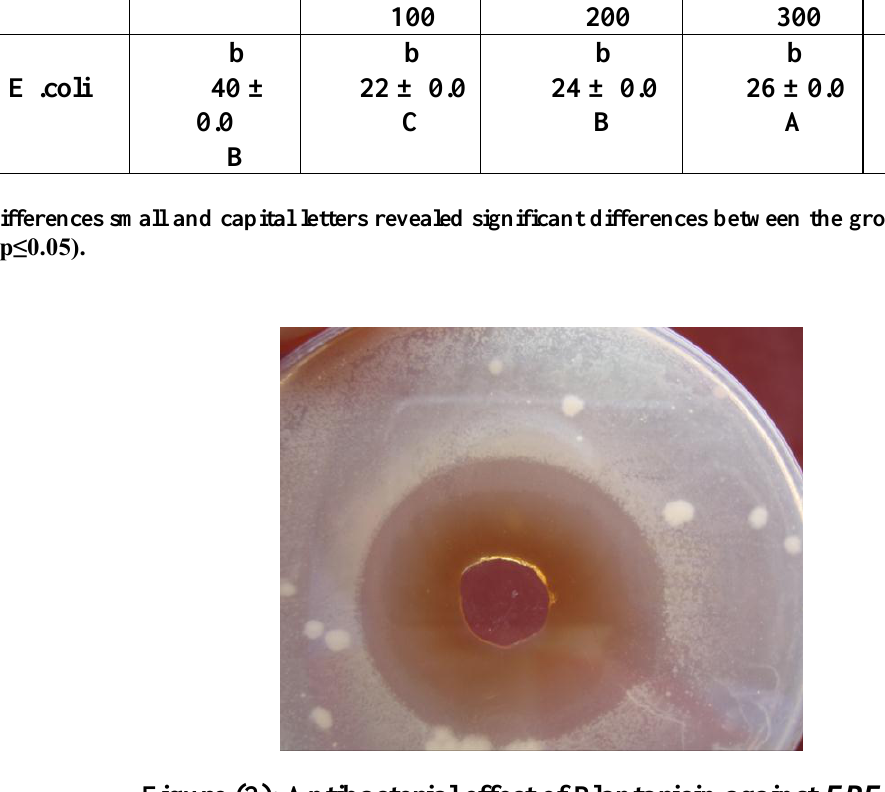
Figure (2): Antibacterial effect of Plantaricin against EPEC.